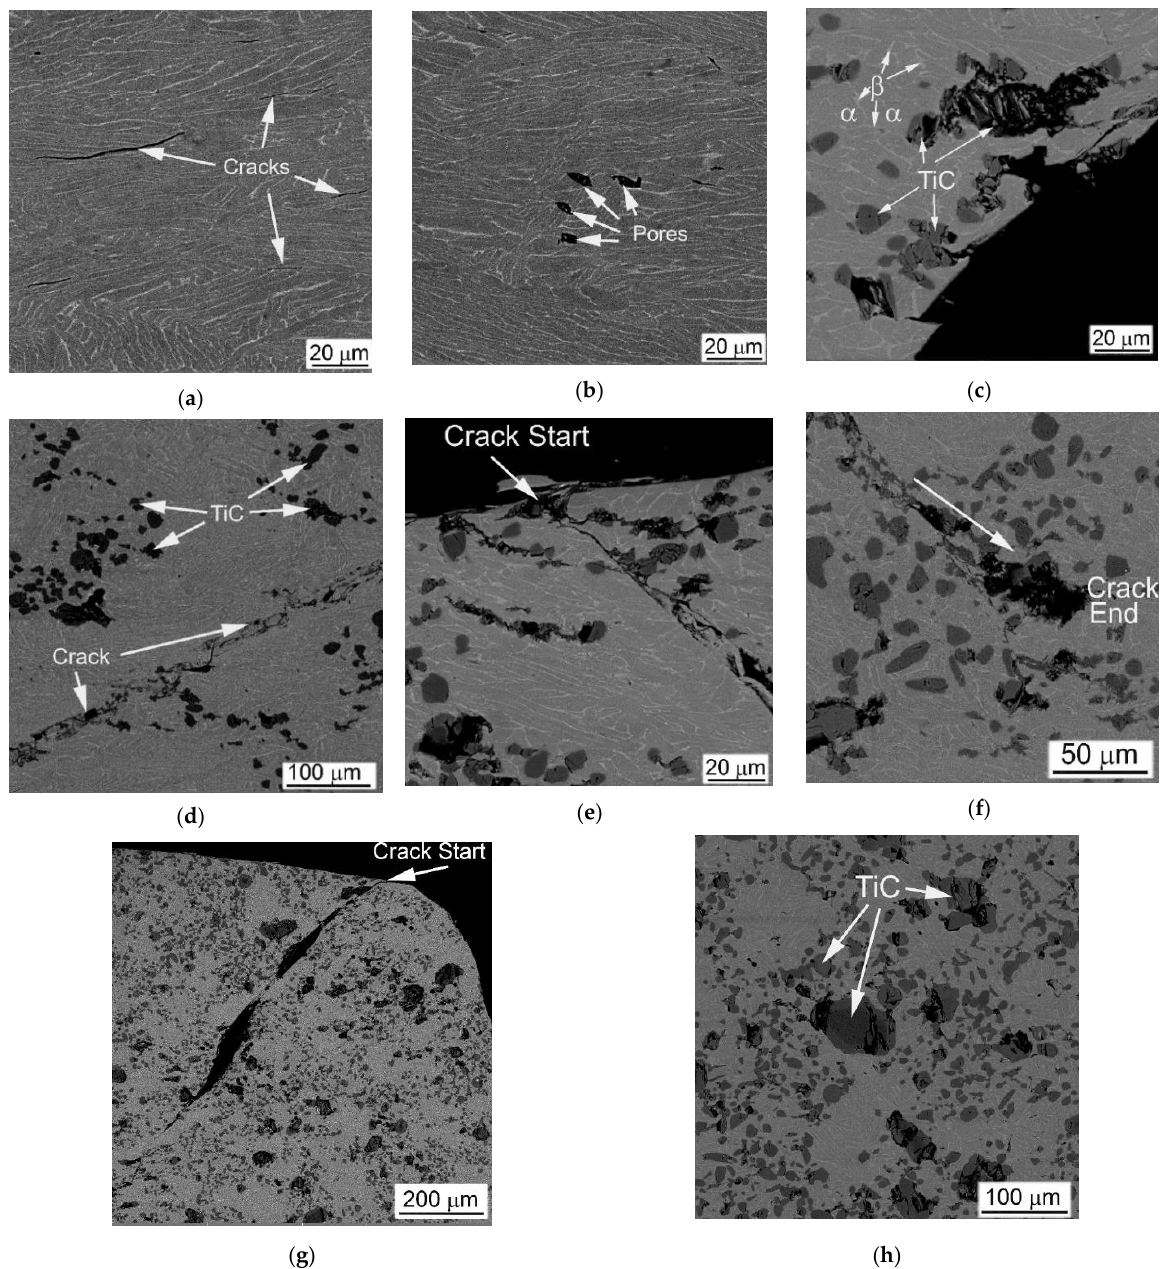
Figure 14. SEM images of samples after QSC tests with rate 10 − 3 s − 1 : ( a , b ) Ti64BEPM, ( c , d ) Ti64BEPM + 5TiC, ( e , f ) Ti64BEPM + 10TiC, and ( g , h ) Ti64BEPM + 20TiC. ( a , b , d , h ) Zone IV, ( c ) Zone II, ( e , g ) Zone I, and ( f ) Zone III. BSE.